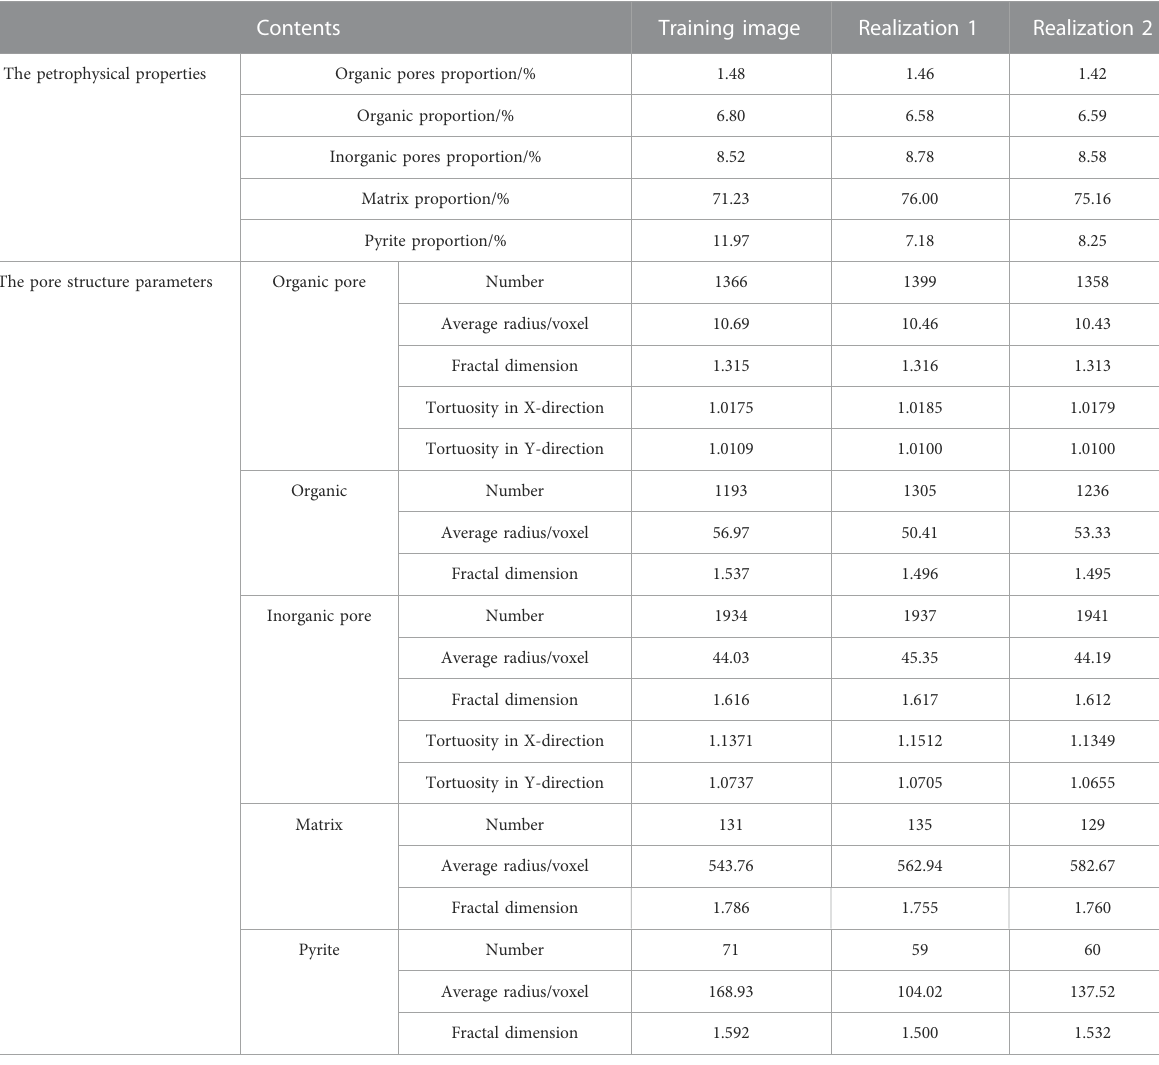
TABLE 1 Petrophysical properties and pore structure parameters of the training image and two realizations obtained by the proposed